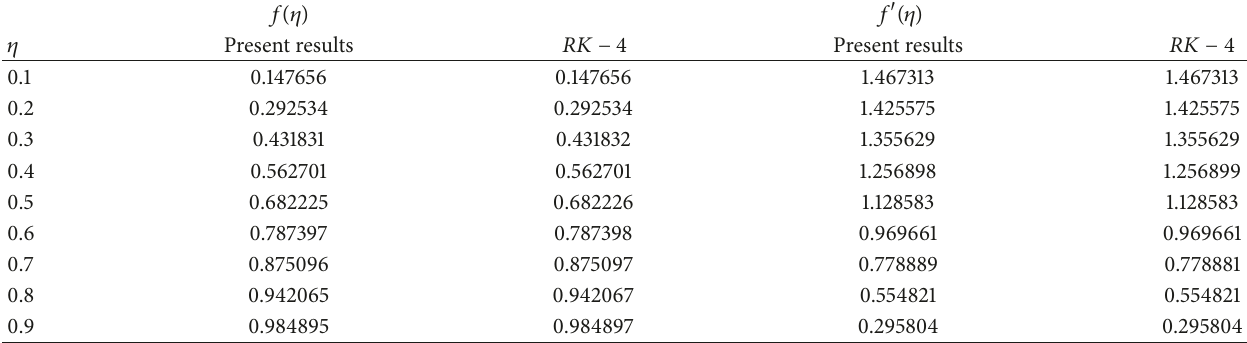
Table 5: Comparison between the solution of present algorithm and 𝑅𝐾 − 4 algorithm for 𝑀 = 1 , 𝛾 = 0.2 , 𝑆 = 1 .